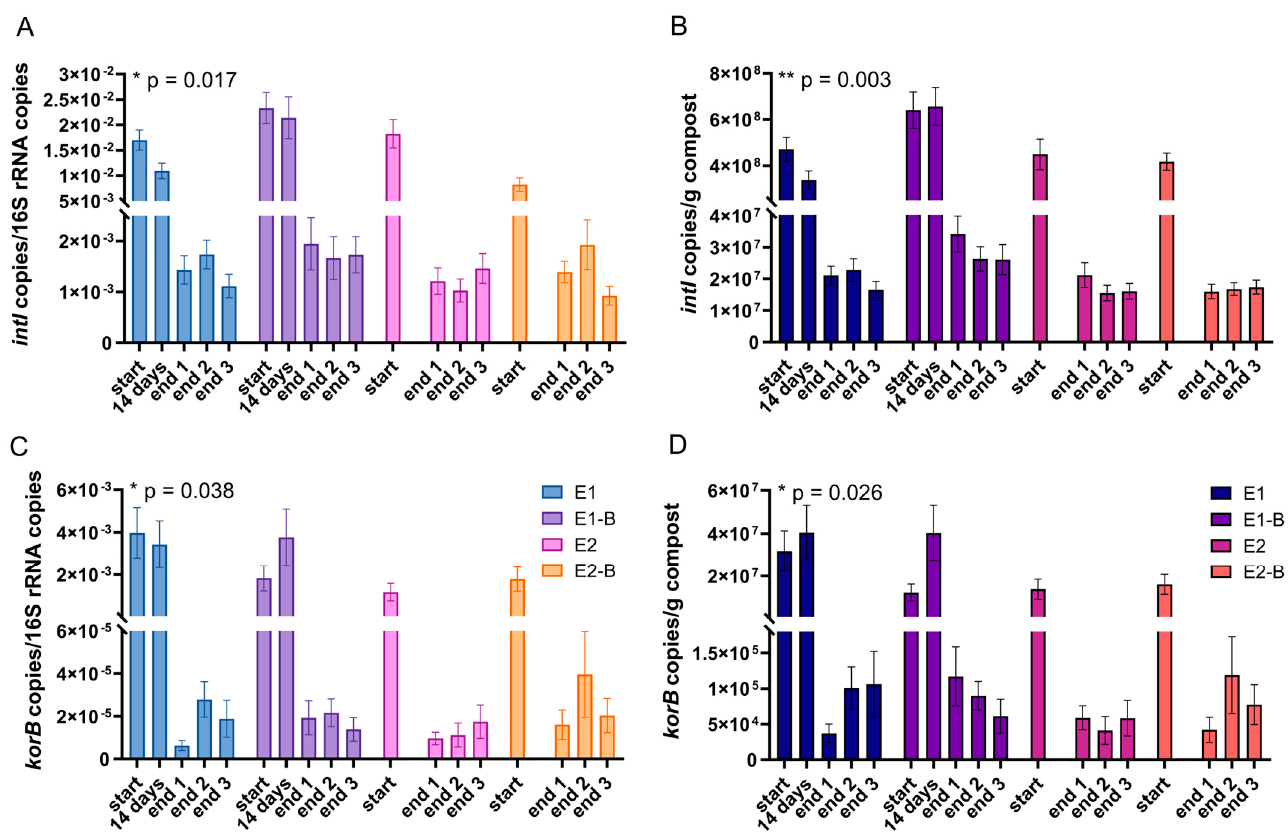
Figure 2. Copy numbers of the class 1 integron-integrase gene intI1 ( A , B ) and IncP-1 marker gene korB ( C , D ) as assessed by qPCR. Copy numbers were normalized to 16S rRNA gene copy numbers (left charts) and to 1 g compost (right charts). Bars represent the average of three individual qPCR measurements with the standard deviation. Start samples, 14-days samples (only repetition 1) and end samples are depicted individually for the first (E1, E1-B) and second repetition of composting (E2, E2-B). End samples comprise replicates from the front (end 1), middle (end 2) and back (end 3) of each compost pile. Asterisks indicate the p -values obtained from Student’s t-test (* p < 0.05, ** p < 0.01) representing the statistical significance of the data. The p -values were calculated to compare start with end samples of composting for all four compost piles combined (average of the triplicate end samples, no differentiation of the treatments).